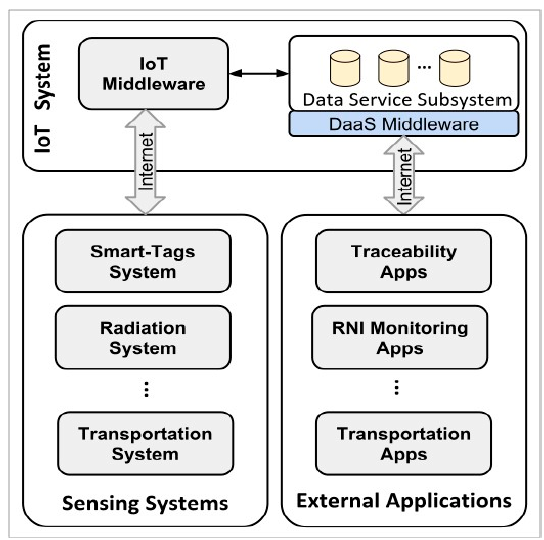
Figure 2. Internet of Things (IoT) Platform.